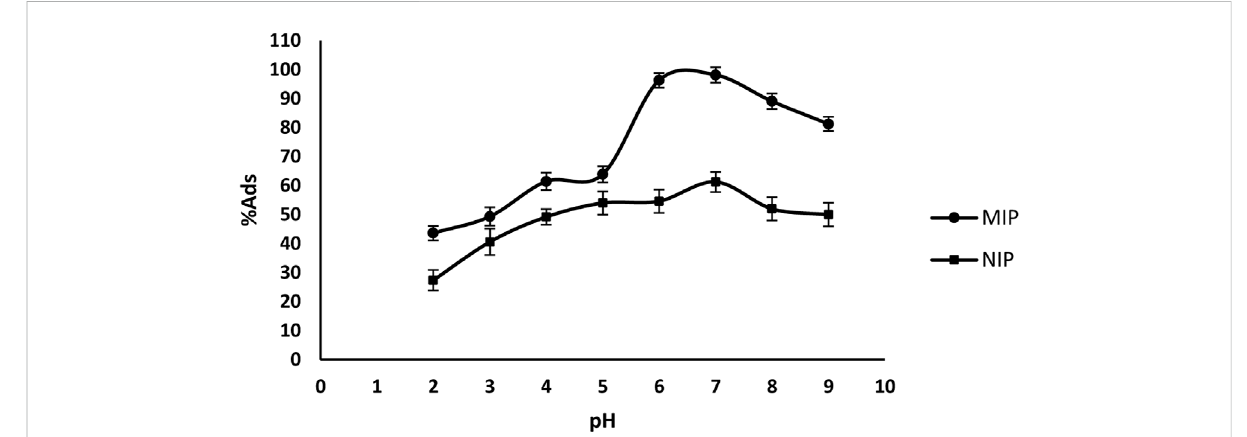
FIGURE 4 The adsorption of oxycodone drug by MIP and NIP in different pHs.